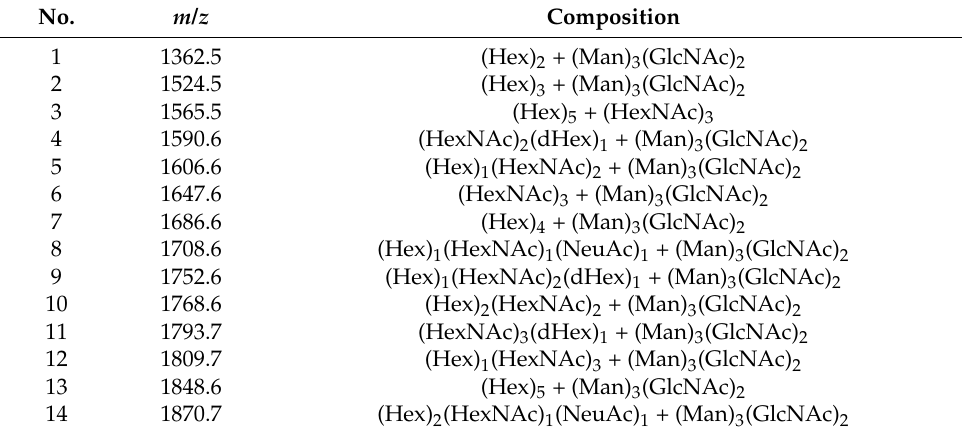
Table 1. Thirty-six types of N -glycans that showed good quantitative reproducibility in all samples and could be analyzed